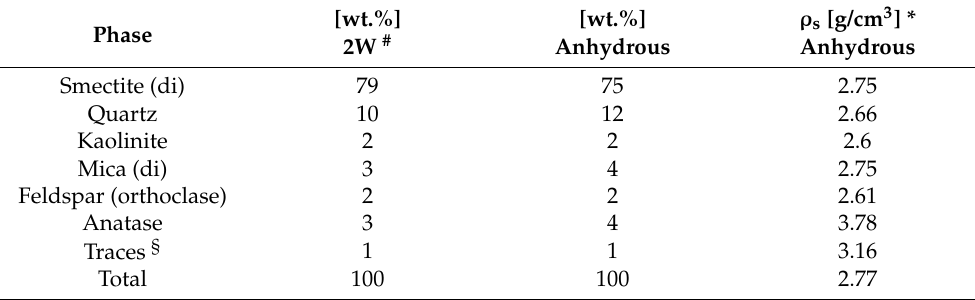
Table 1. Phase content determined by XRD and specific grain density * of Secursol UHP.